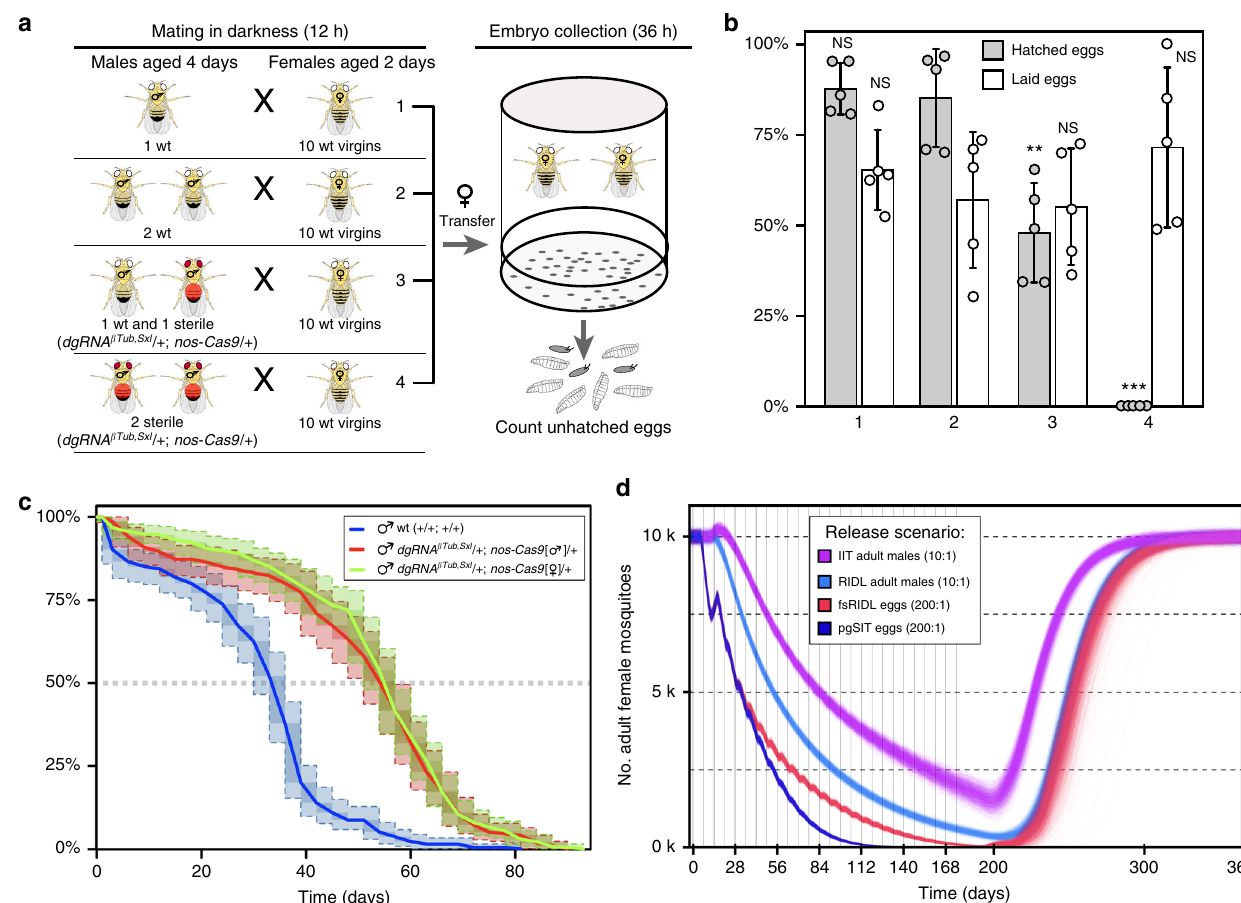
Fig. 4 Competitiveness and longevity of pgSIT males and modeling data. a An experimental setup to estimate the mating competitiveness of dgRNA β Tub,Sxl / + ; nos-Cas9/ + sterile males (marked with red) competing against wt males to secure matings with wt females. A mated female is resistant to the next mating for around 24h 64,69 , and the mating success of sterile males was evaluated by fertility decrease (aka. increase of unhatched egg rate). b Bars graph percentages of laid and hatched eggs (Supplemental Table 8). The presence of one sterile male resulted in a signi fi cant decrease in female fertility (#3 vs. #2) that could not be accounted by removal of one wt male (#2 vs. #1). Bars represent means ±SD for fi ve replicates. #3 to #2 and #1 P> 0.003**, P > 0.0001*** by a t test assuming unequal variance. c Survival curves of wt males (blue line) and two types of dgRNA β Tub,Sxl / + ; nos-Cas9/ + sterile males, with paternal (red line) or maternal (green line) Cas9 inheritance. Survival curves show nonparametric maximum likelihood estimates for three male groups, along with 95% con fi dence intervals in light shade and dark shade for representational nonuniqueness. The y -axis shows the estimated survival percentage. Both types of pgSIT males lived signi fi cantly longer than wt males ( P< 2.2 – 16 ), while no signi fi cant difference was found between two types of pgSIT males by Sun ’ s generalization of